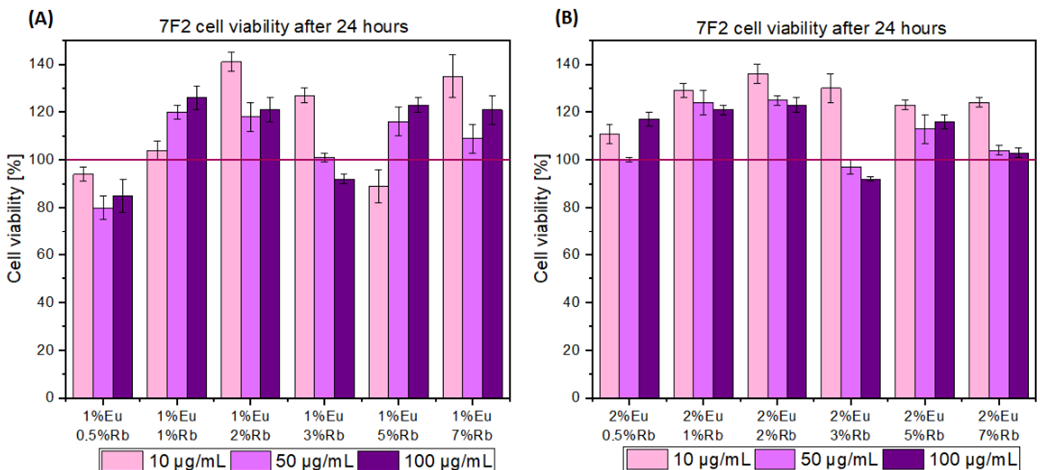
Figure 8. MTT cytotoxicity assay of ( A ) Ca 10 − (0.1 + x) Eu 0.1 Rb x (PO 4 ) 6 (OH) 2 and ( B ) Ca 10 − (0.2 + x) Eu 0.2 Rb x (PO 4 ) 6 (OH) 2 , where x equals 0.5, 1, 2, 3 mol% of Rb + ions. The final concentration of the tested compounds was established at 10 µg/mL, 50 µg/mL, and 100 µg/mL. Red bar marked as 100% of cell viability in the negative control probe.